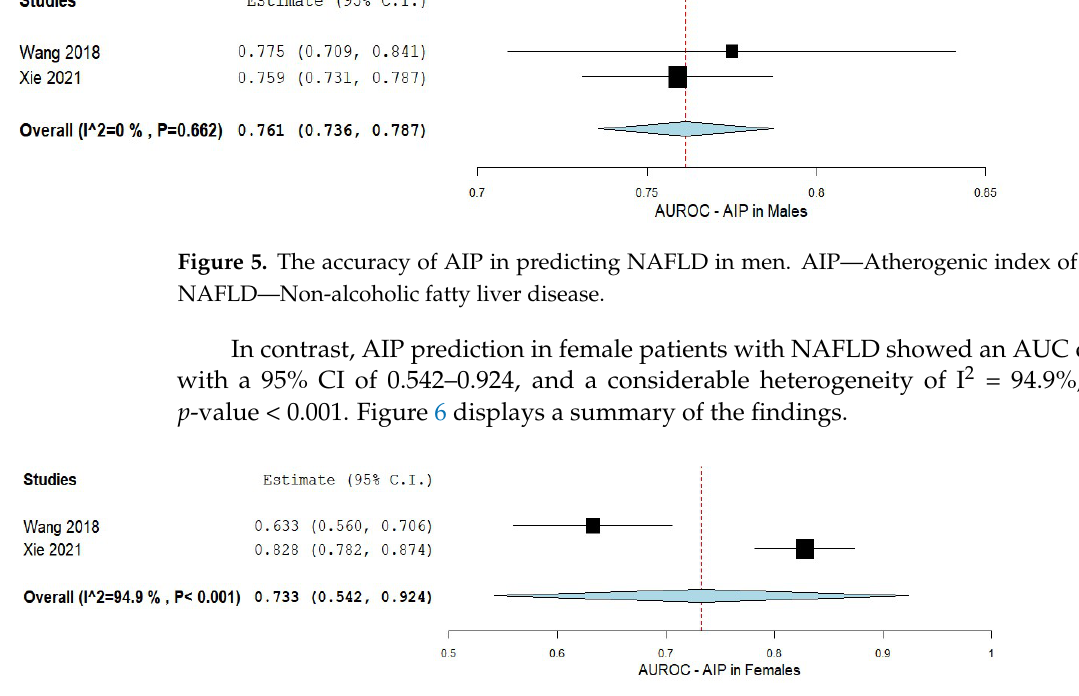
6 of 13 Figure 4. The accuracy of the AIP in predicting NAFLD . AIP—Atherogenic index of plasma; NAFLD—Non-alcoholic fatty liver disease. 3.6. AIP in Predicting NAFLD Based on Sex The accuracy of AIP in predicting NAFLD in patients of both male and female sexes was assessed using data from two studies. The findings of the pooled analysis for males are shown in Figure 5 [5,52]. The analysis showed an AUC of 0.761 with a 95% CI of 0.736−0.787. A non-significant heterogeneity was composed of an I 2 = 0% and p -value =